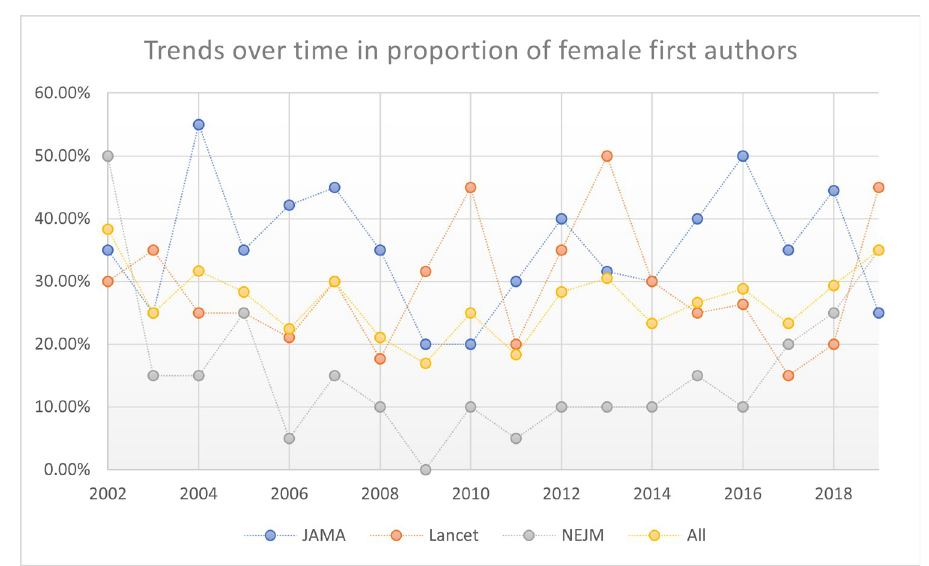
Fig 2. Trends over time in proportion of first authors by gender.